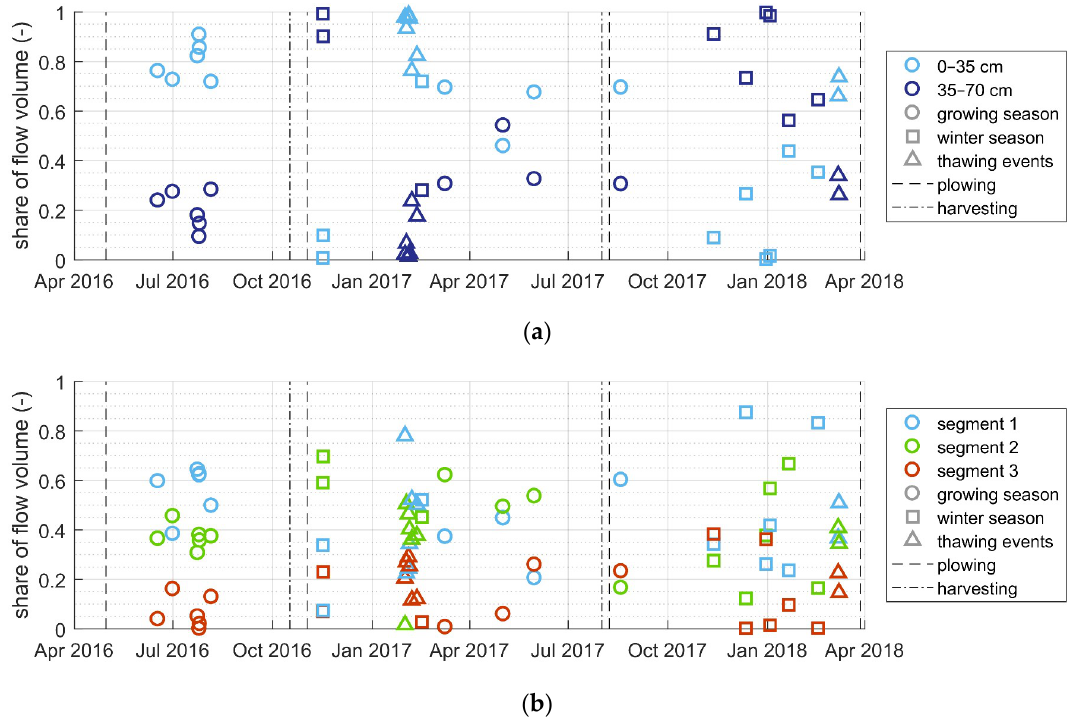
Figure 9. Temporal occurrence of subsurface flow shares for di ff erent events at the cropland site: ( a ) vertical subsurface flow volume shares; ( b ) horizontal subsurface flow volume